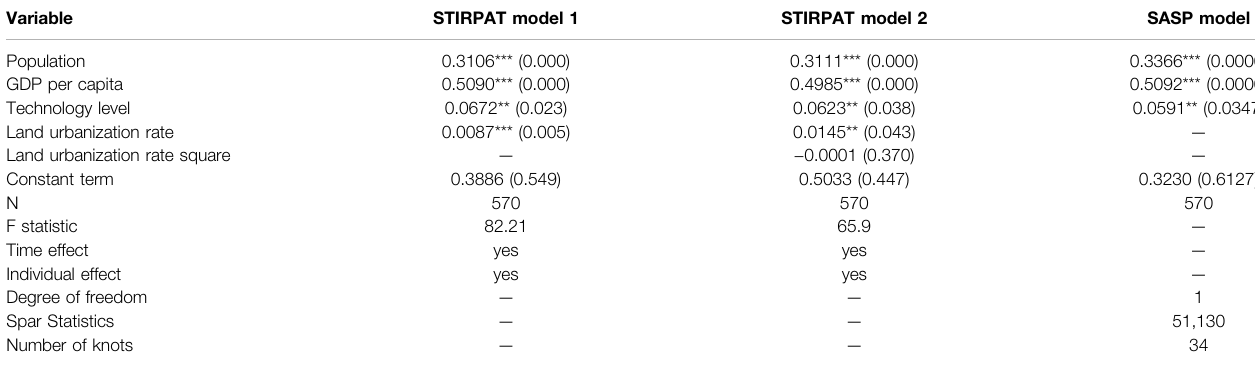
TABLE 2 | Estimating results between land urbanization and total CO 2 emissions based on the parametric and semiparametric model. Variable